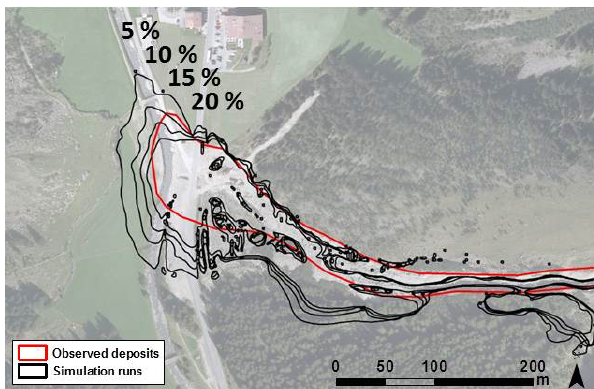
Figure 6. Variations of stopping criteria using the RAMMS–DF model for the Reiselehnrinne Creek case study. Outlines of the sim- ulations are presented in black; observed deposits are given in